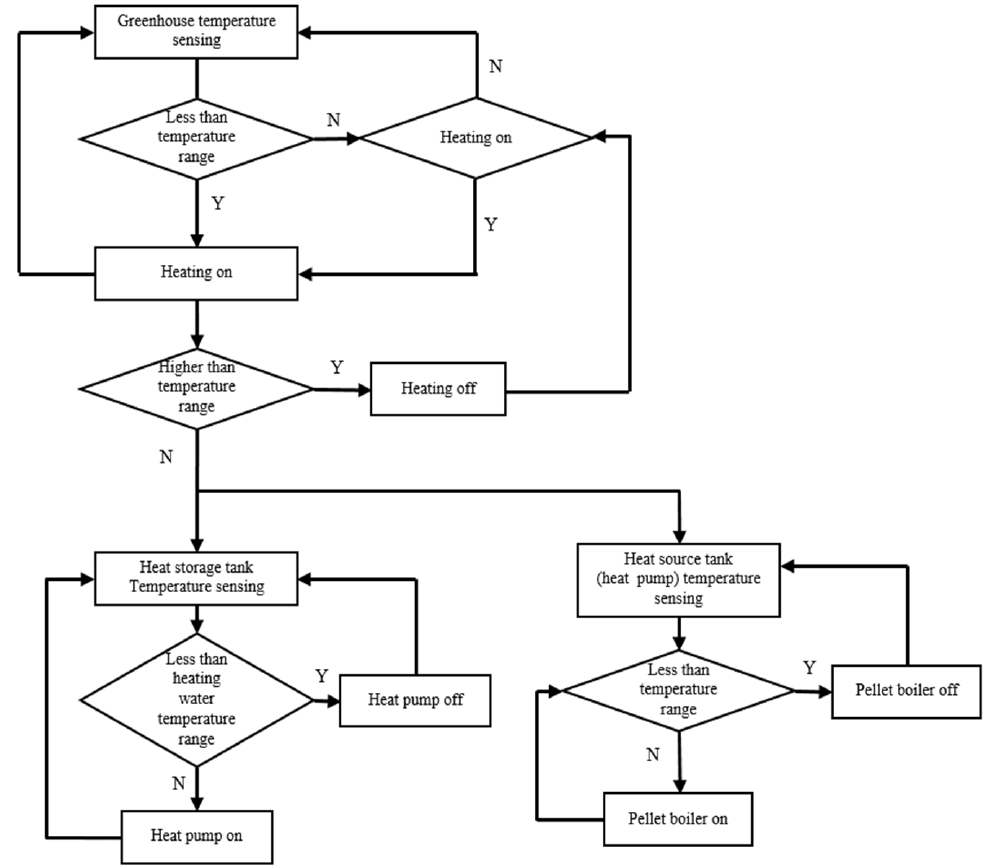
Figure 4. Control logic of hybrid system 1.